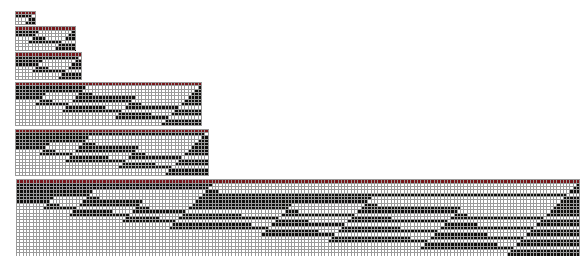
Figure 7: Execution of machine 582 263 on the first six inputs and their corresponding space-time